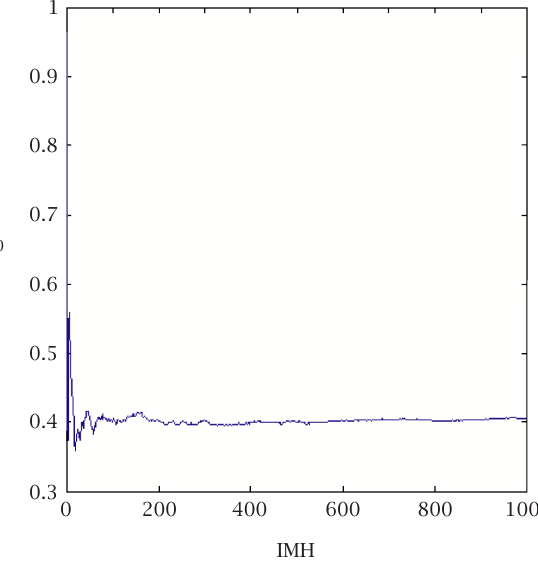
Figure 4.1 . Convergence of ˜ p